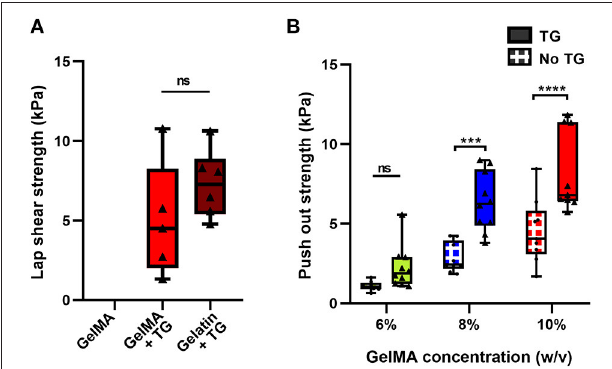
FIGURE 5 | Quantification of the adhesive ability of GelMA with transglutaminase against cartilage tissue (A) Lap shear analysis of 10% GelMA with transglutaminase against bovine cartilage, in comparison to GelMA only and 10% gelatin with transglutaminase as controls. Individual data points are plotted with box and whisker plots indicating the median and interquartile ranges. Significance was assessed with an unpaired t -test. (B) Push out test results for three concentrations of GelMA with and without transglutaminase. Individual data points are plotted with box and whisker plots indicating the median and interquartile ranges. Significance was assessed with two-way ANOVA and Bonferroni post-hoc test. *** p < 0.001, **** p < 0.0001. Triangle symbols and solid shaded boxes are used to indicate samples that contained transglutaminase, and circle symbols with hatched boxes are used to indicate